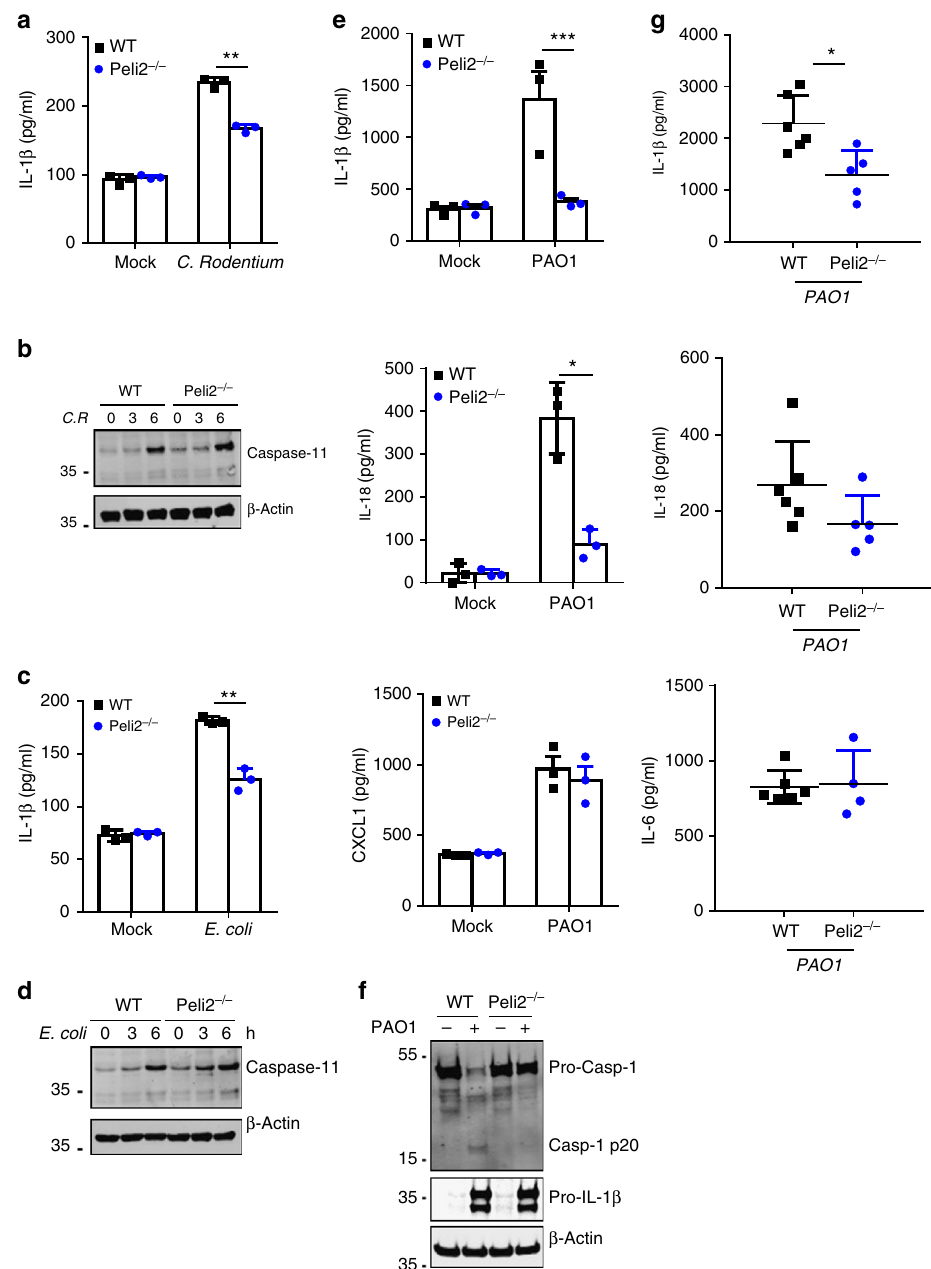
Fig. 4 Pellino2 mediates activation of the NLRP3 pathway in response to bacterial infection. a-f WT and Peli2 − / − BMDMs were infected with a, b C. rodentium , c, d E.coli , or e, f P. aeruginosa (PA01 strain) at a multiplicity of infection (MOI) of 100. a, c, e ELISA of IL-1 β , IL-18, and CXCL1 in medium from BMDMs infected for 6 h. b, d Immunoblot analysis of Caspase-11 in lysates from cells infected for 0 – 6 h. f Immunoblot analysis of IL-1 β and Caspase-1 in lysates from cells infected with PAO1 for 3 h. β -Actin was used as loading controls. g ELISA of IL-1 β , IL-18, and IL-6 in peritoneal lavage from WT and Peli2 − / − mice previously infected for 10 h by intraperitoneal injection of PAO1 (1.5 × 10 7 CFU). * p < 0.05, ** p < 0.01 (paired, two-tailed Student ’ s t -test). Data represent the mean ± s.e.m. of three independent experiments ( a, c, e ), biological replicates that are representative of 3 independent experiments ( b, d, f ), or samples from individual mice ( n = 4 – 6 per group) ( g